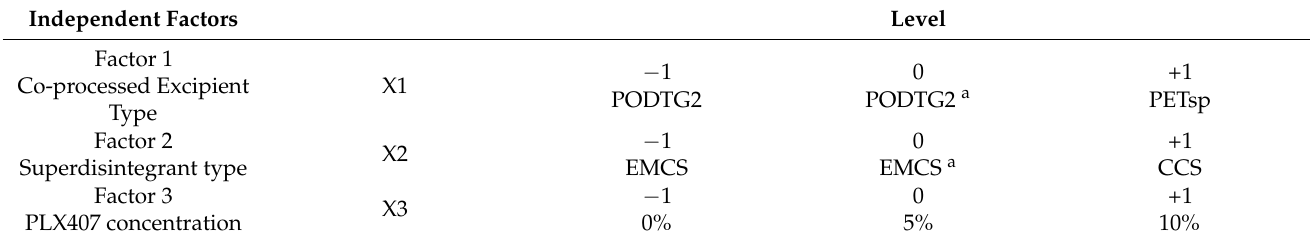
Table 2. Independent parameters included in the